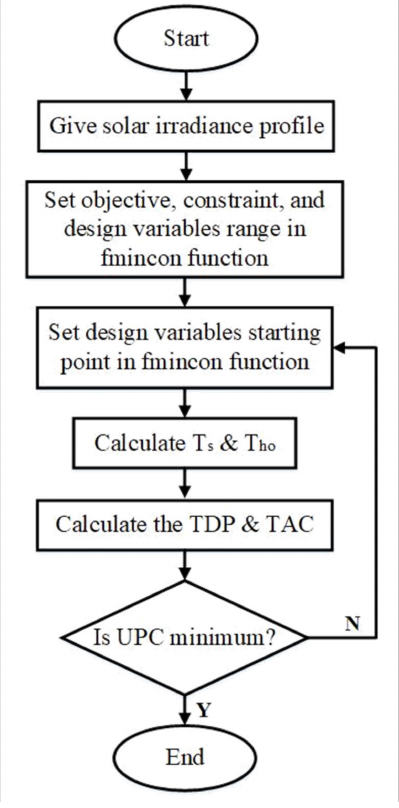
Figure 6. Flow chart of optimization with MATLAB